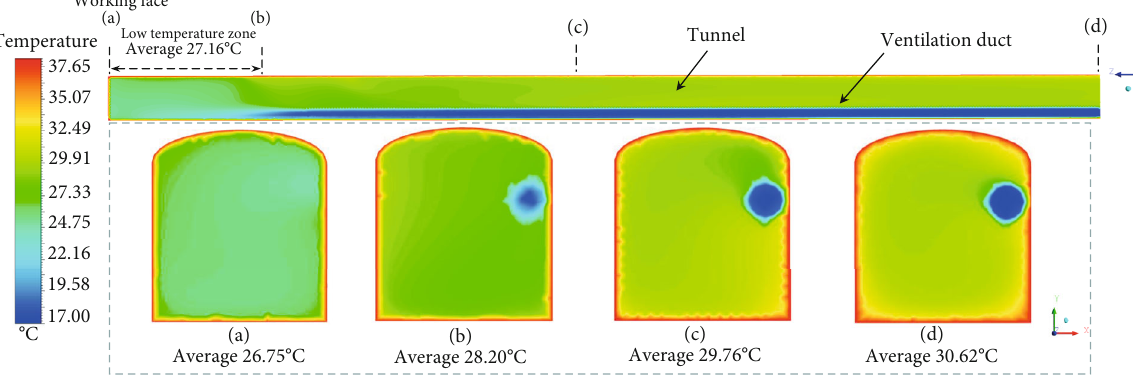
Figure 4: Temperature distribution diagram of tunnel under the condition of air supply temperature of 17 °